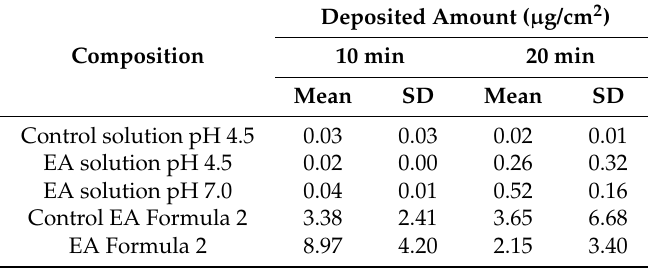
Table 4. Deposited amount of EA obtained with EA solution at pH 4.5 and 7.0 and EA Formula 2 applied after 10 min and 20 min current